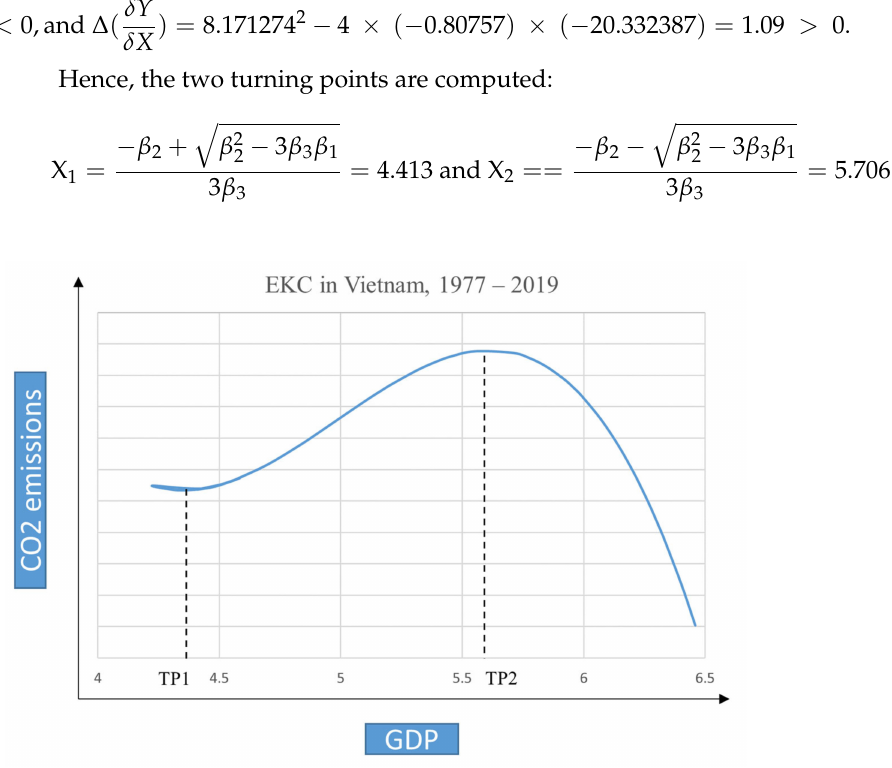
Figure A3. The inverted N-shaped of the EKC in Vietnam,